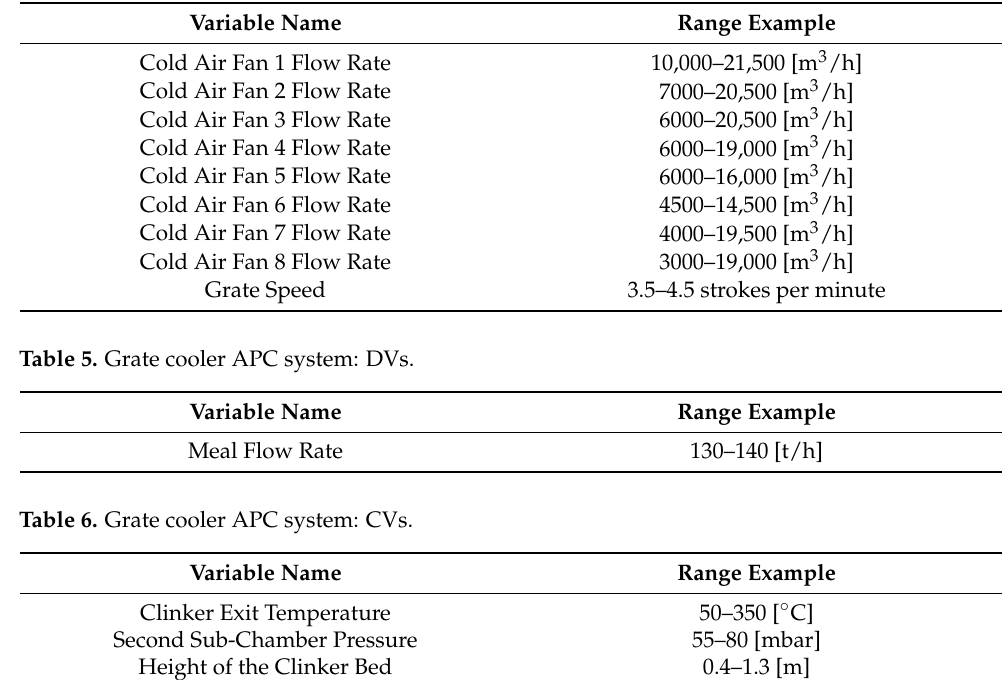
Table 4. Grate cooler APC system: MVs.